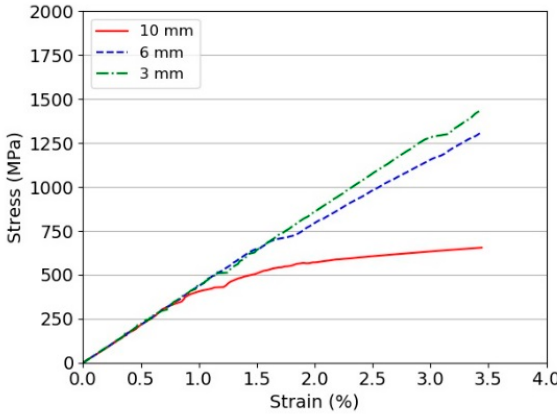
Figure 17. Virtual tensile testing of a Dyneema ® laminate specimen (thickness 3, 6, and 10 mm) with the same static and dynamic frictional coefficients (0.3).